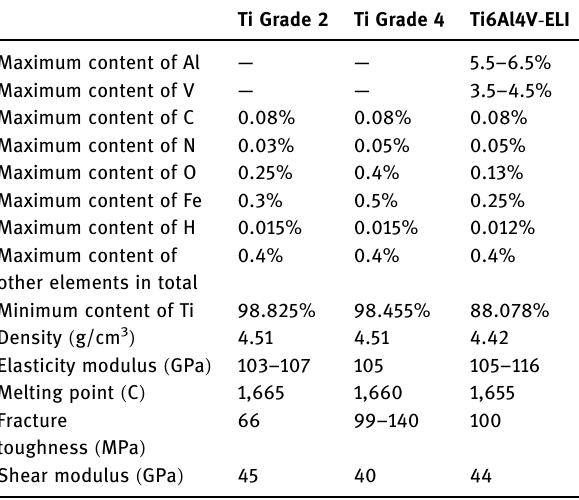
Table 1: Chemical composition and physical characteristics of TiCP2, TiCP4, and Ti6Al4V - ELI ( Ti Grade 23